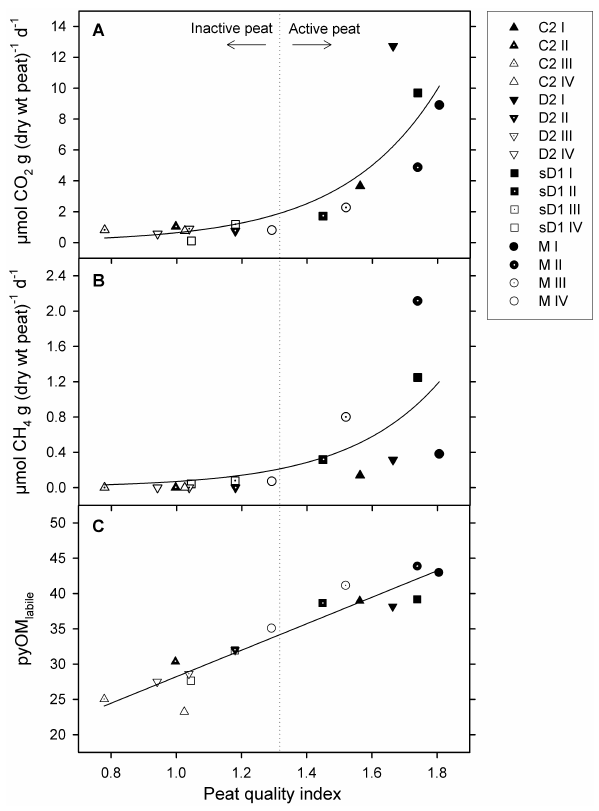
Fig. 3. Correlation of peat quality index as ratio between the sum of thermal labile and recalcitrant C-based compounds and inert carbon compounds, (pyOM labile +pyOM recalcitrant )/pyOM inert , ob- tained with thermogravimetry analyses with formation rates of CO 2 (a) and CH 4 (b) , and proportion of thermal labile particulate or- ganic matter (pyOM labile ) (c) . Peat was sampled at 4 sampling sites along a hydrological gradient of an acidic fen (from the middle to the south C2 → D2 → sD1 → M) over 4 depths (I: 0–10cm, II: 10– 20cm, III: 20–30cm and IV: 30–40cm). The best fit equation for CO 2 formation, CH 4 formation and pyOM labile with peat quality is expressed by: y =0.025e 3 . 19 x ( r 2 =0.71, p < 0.01), y =0.002e 3 . 54 x ( r 2 =0.49, p < 0.01) and y =18.75x+9.5 ( r 2 =0.89, p < 0.01), respec-